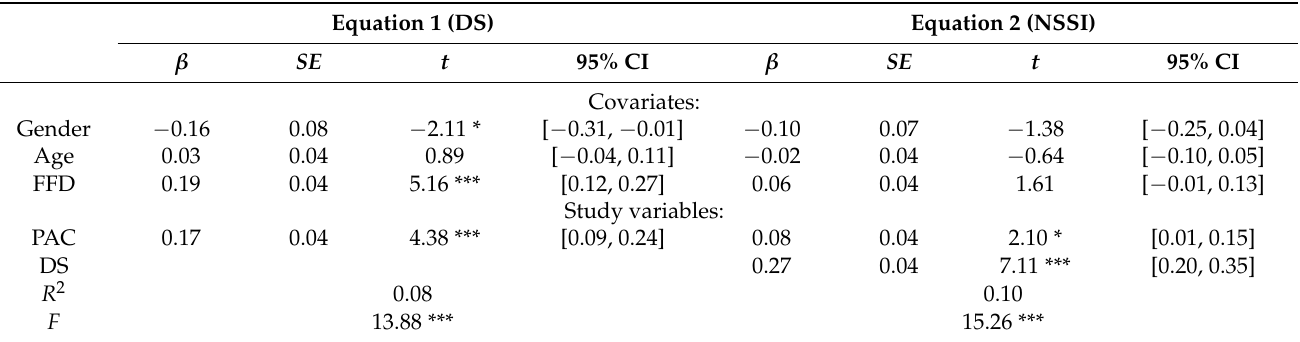
Table 2. Testing for the mediation effect of depressive